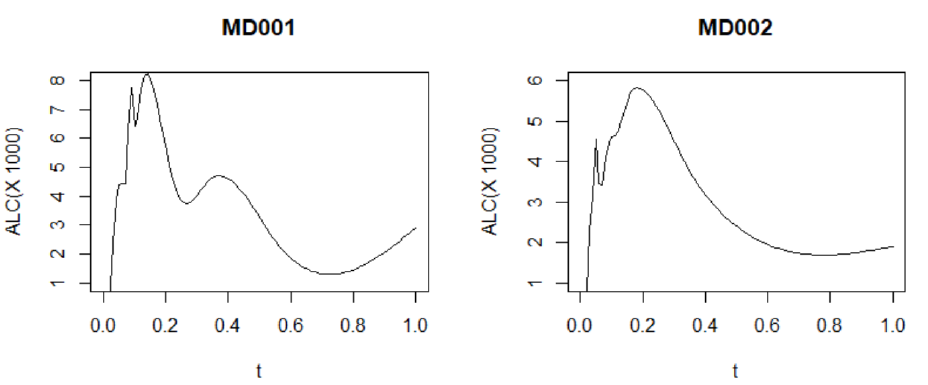
Figure 6. Left panel: trajectory of individual “MD001"; right panel: trajectory of individual “MD002". The observation interval has been scaled to [ 0,1 ]